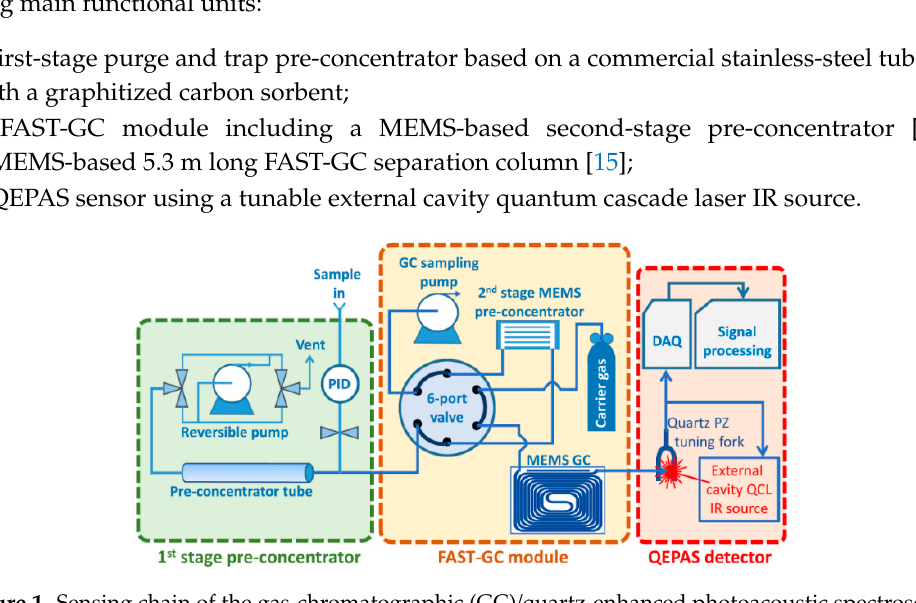
Figure 1. Sensing chain of the gas-chromatographic (GC)/quartz-enhanced photoacoustic spectroscopy (QEPAS) sensor.